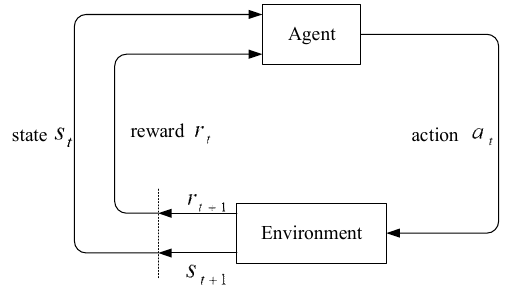
Figure 1. Reinforcement learning schematic.